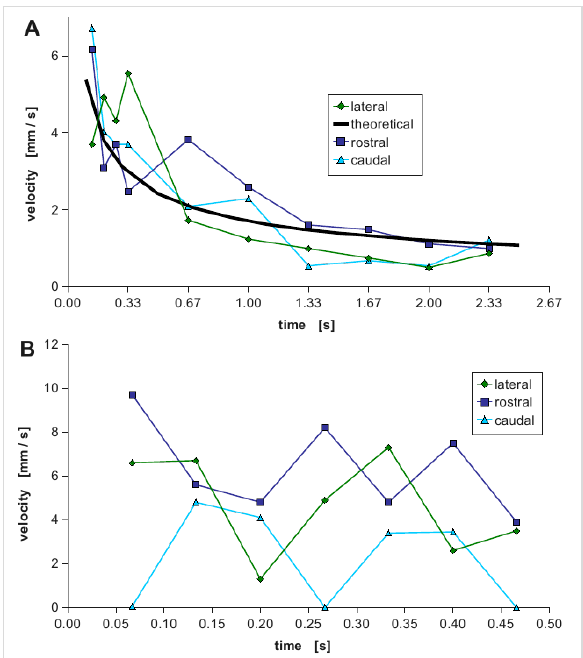
Figure 9: Water transport velocity in the capillary system. Two typical examples of results of a frame-to-frame analysis of videos showing the transport of coloured water in the capillaries are shown for Phryno- cephalus arabicus (A) and Phrynosoma cornutum (B). The velocities were measured in direction to the mouth (rostral, dark blue squares), towards the tail (caudal, light blue triangles) and sidewards (lateral, green diamonds). For Phrynocephalus arabicus (A) no significant difference can be seen when comparing the velocities in the different directions. The theoretical behaviour described by the Washburn- equation (solid black line) fits the data quite well suggesting simple capillary transport uniformly flowing in all directions. In contrast for Phrynosoma cornutum the typical result is that the velocity has a